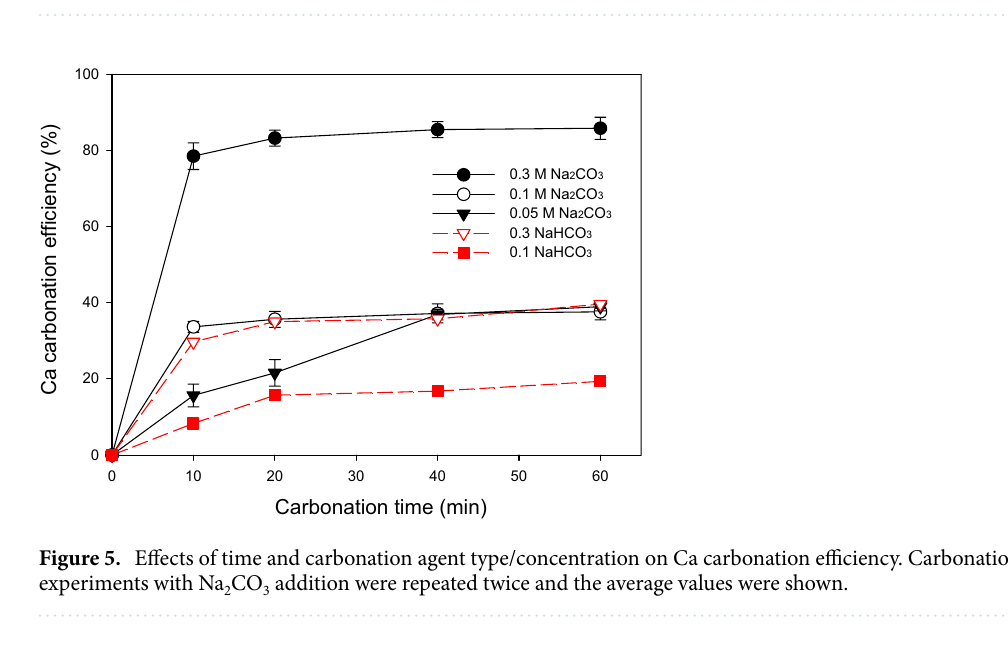
Figure 4. The changes of Ca concentrations (or extraction ratio, %) with dissolution time in the presence of 0−0.3 M GLDA.